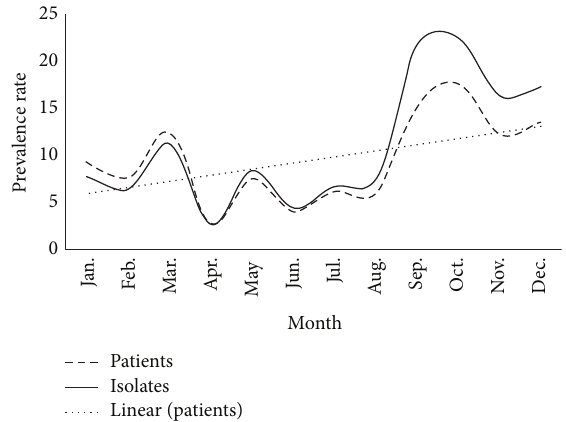
Figure 1: Prevalence rates of hospital-acquired multidrug resistant organisms (MDRO) at SQUH, Oman, 2012.